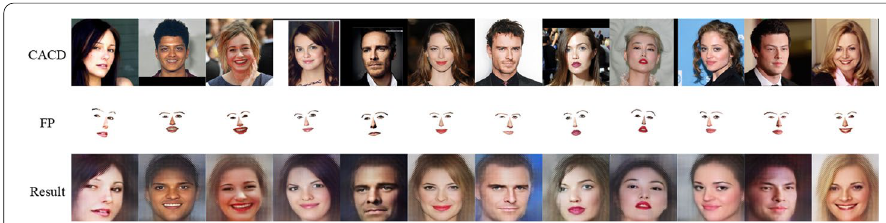
Fig. 11 Apply the model trained on CelebA to the CACD dataset. The first row is randomly selected images from CACD, and the last row is a synthetic portrait of our model. (FP is short for facial parts.)